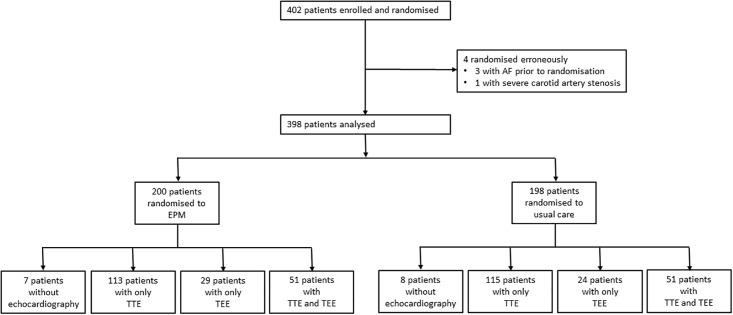
Trial profile of the present analysis.